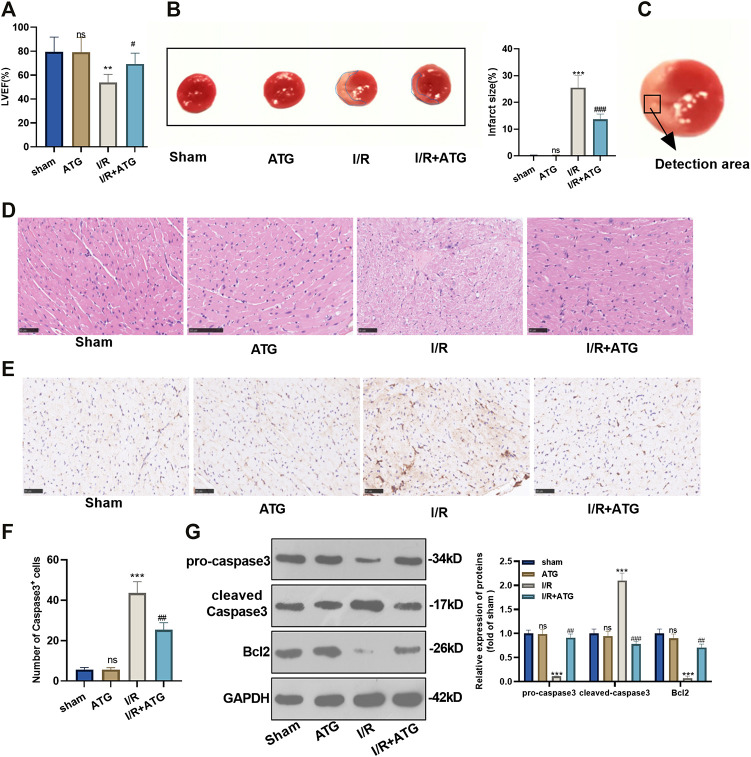
Arctigenin remarkably mitigated the AMI/R-induced myocardial damage in vivo. The LAD permanent ligation method was performed to establish a rat MI model in vivo, and Arctigenin was given (100 µmol/kg, intraperitoneal injection), and the heart tissue was taken on the 21st day. (A) Change of LVEF of rats. (B) TTC staining was used to detect the AMI/R area in each group. (C) The detected area was shown. (D) HE staining explored the arrangement of myocardial fibrous tissue and inflammatory cell infiltration. (E) and (F) The number of Caspase3 positive cells was examined via immunohistochemistry. (G) Western blot test detection for the expression of apoptosis-related proteins caspase3 and Bcl2. nsP >0.05, ***p < 0.001 (vs.sham group), #p < 0.05, ##p < 0.01, ###p < 0.001 (vs.IR group), N = 5.